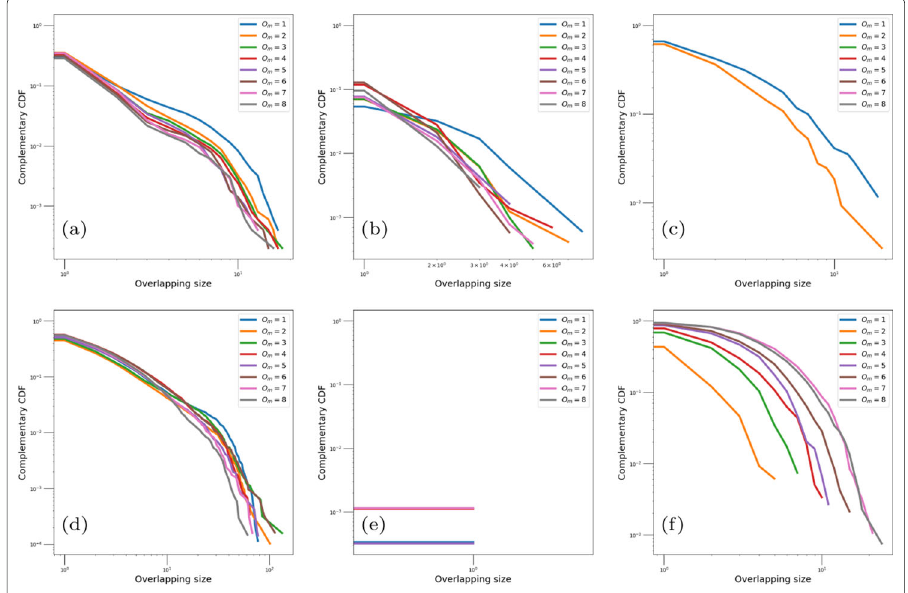
Fig. 18 Variation of the maximum number of memberships ( O m ) for LFR synthetic networks considering the overlapping size: a Bigclam; b CFinder; c Copra; d Demon; e SLPA; f